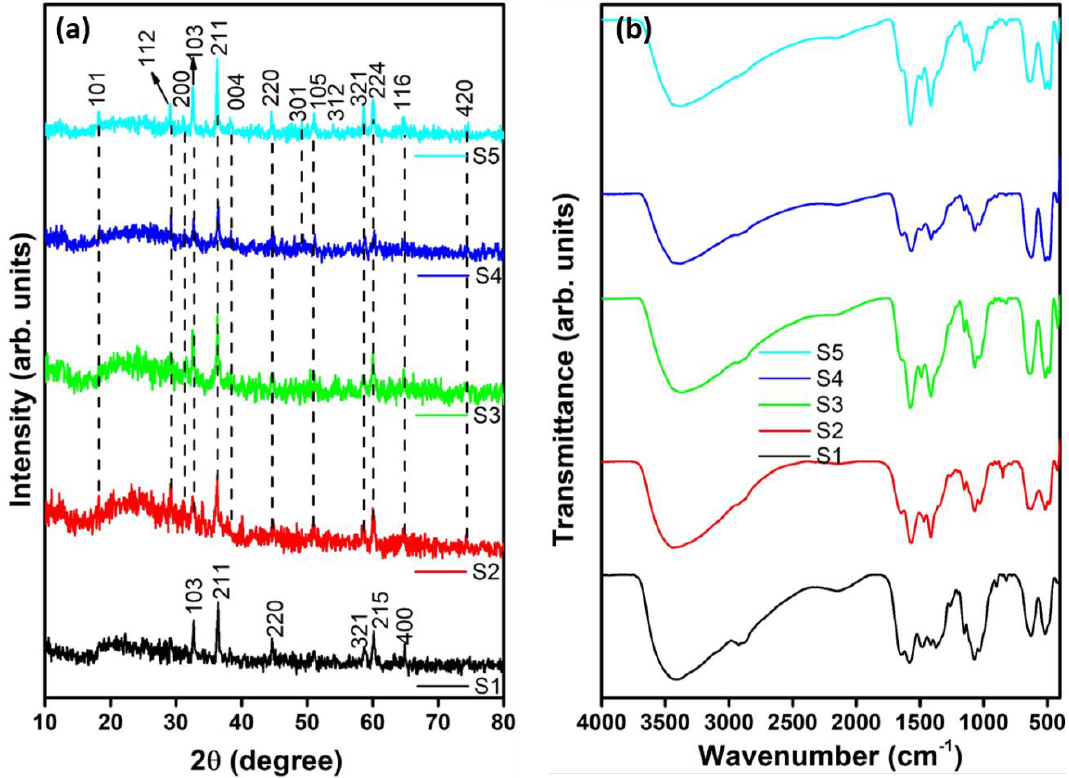
Figure 1. ( a ) XRD and ( b ) FTIR profiles of nanocomposites S1–S5.